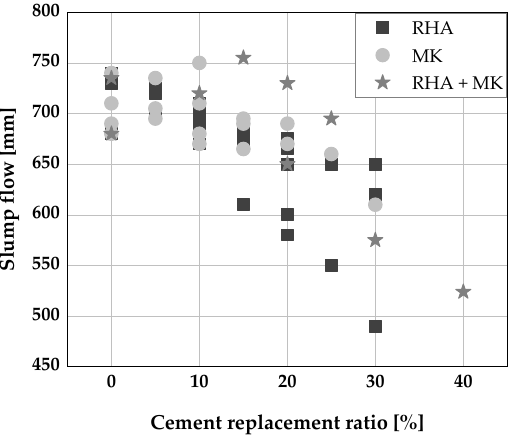
Figure 2. Slump flow of self-compacting concrete (SCC): Kannan [30], Chopra et al. [31], Rahman et al. [106], Madandoust [34], Gill [61].